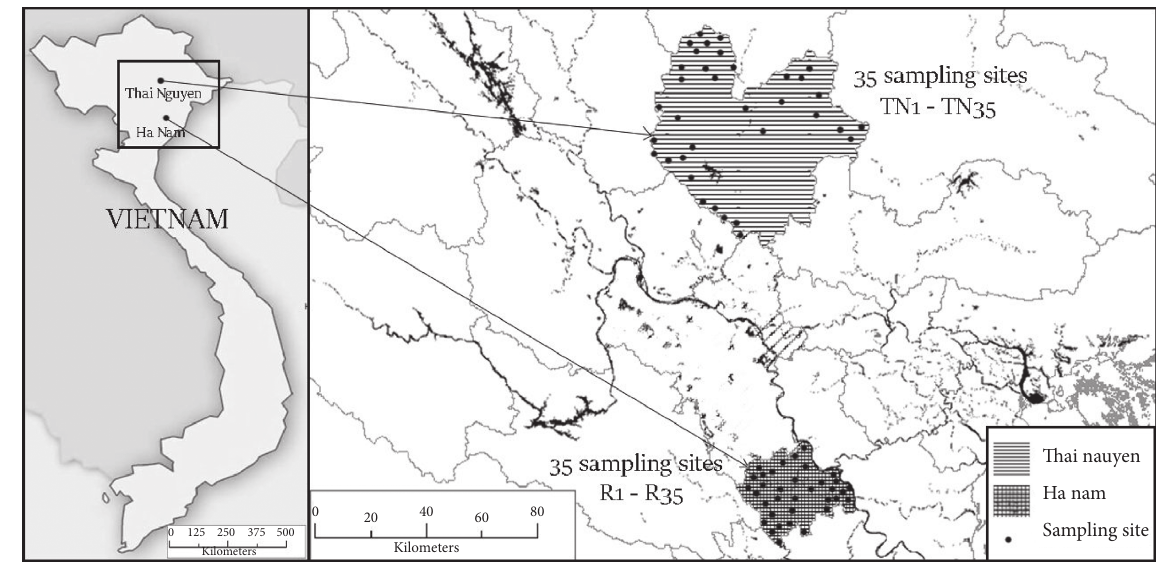
Figure 1: Maps of sampling sites, Thai Nguyen and Ha Nam Table 1: Characteristics of the analytical method for the analysed rice samples.